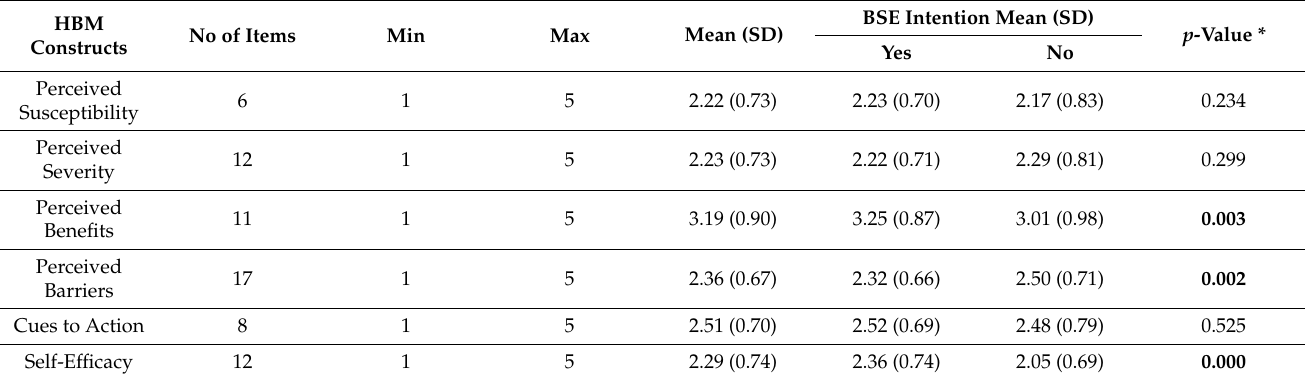
Table 3. Mean scores on the Health Belief Model subscale.